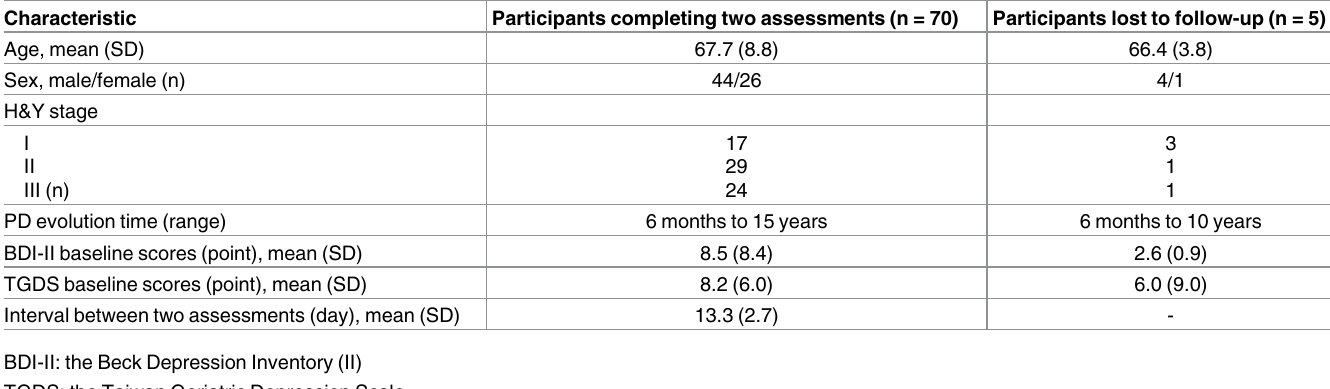
Table 1. The demographic and clinical characteristics of the participants. Characteristic Participants completing two assessments (n =